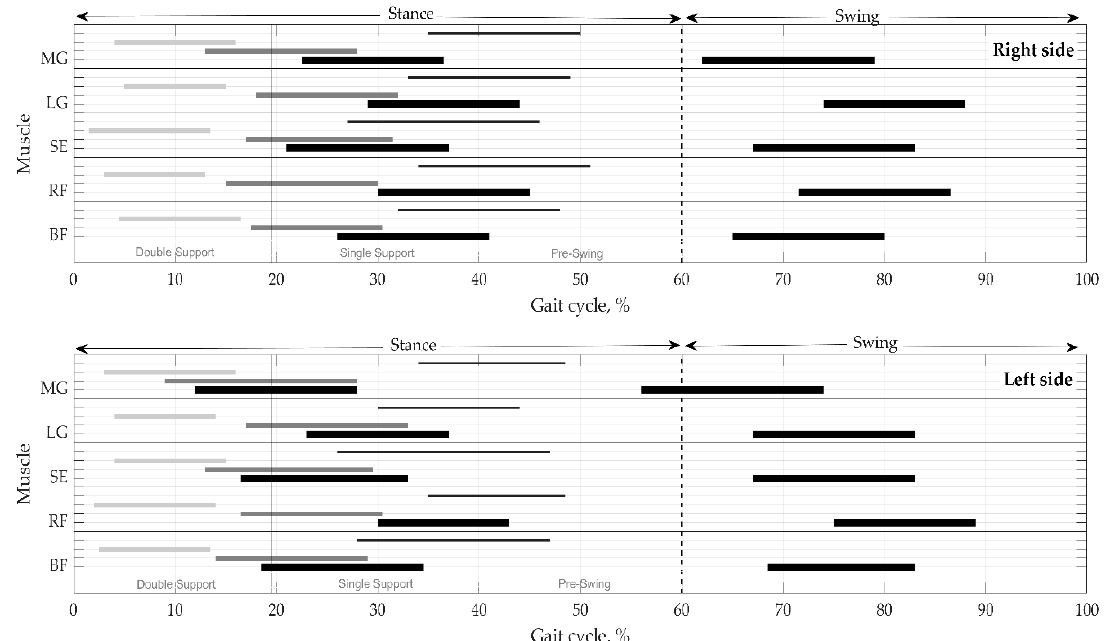
Figure 4. Distribution of muscular activation pattern on the right and left sides. Values presented as medians without mad. Thick black lines indicate the mean duration of activity in the main phases—stance and swing. Thin black, thick gray, and light gray lines reflect the mean values of activations in the subphases, respectively, in pre-swing, single support, and double support. BF—biceps femoris, RF—rectus femoris, SE—semitendinosus, LG—lateral gastrocnemius, and MG—medial gastrocnemius. Table 6. Descriptive values of activation duration and SI for each muscle.